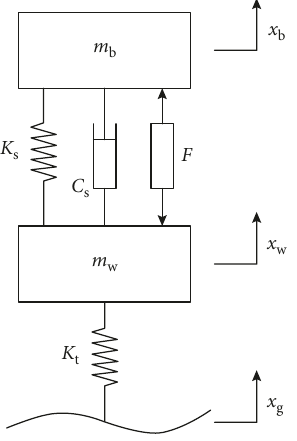
Figure 3: 2-DOF quarter-car